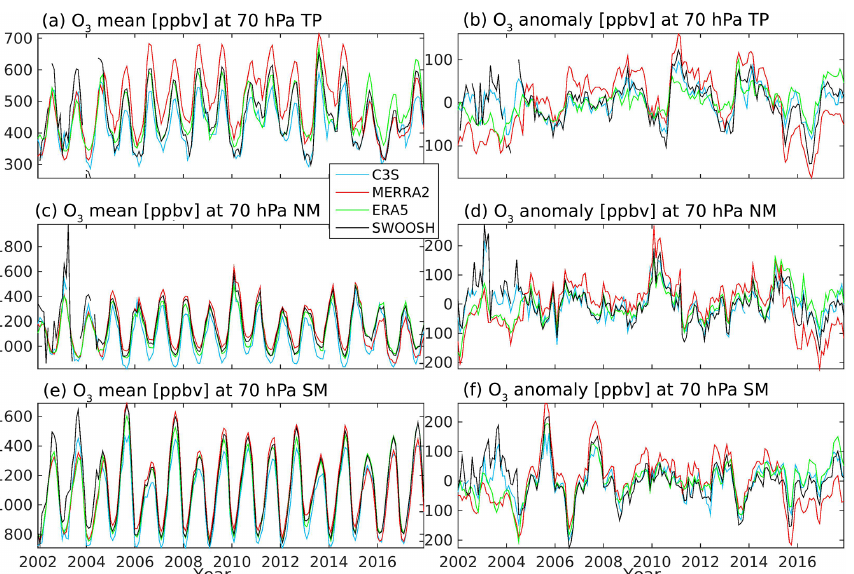
Figure 14. Monthly mean ozone in ppbv at 70hPa through three latitude bands of TP (10 ◦ S–10 ◦ N) (a) , NM (25–45 ◦ N) (c) , and NM (25– 45 ◦ S) (e) . Corresponding anomalies in panels (b) , (d) and (e) . Model with 103 levels (margin), ERA5 (green), C3S (light blue), MERRA2 (red) and SWOOSH (black) are included. The dashed black lines mark the tropopause height calculated with GNSS RO data.